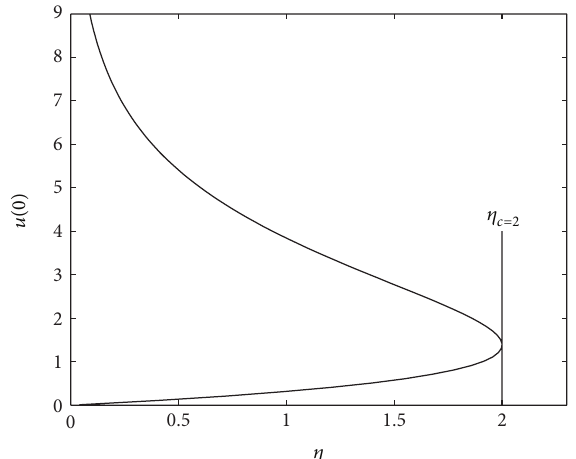
Figure 2: Bifurcation diagram for Frank-Kamenetzkii problem (8).